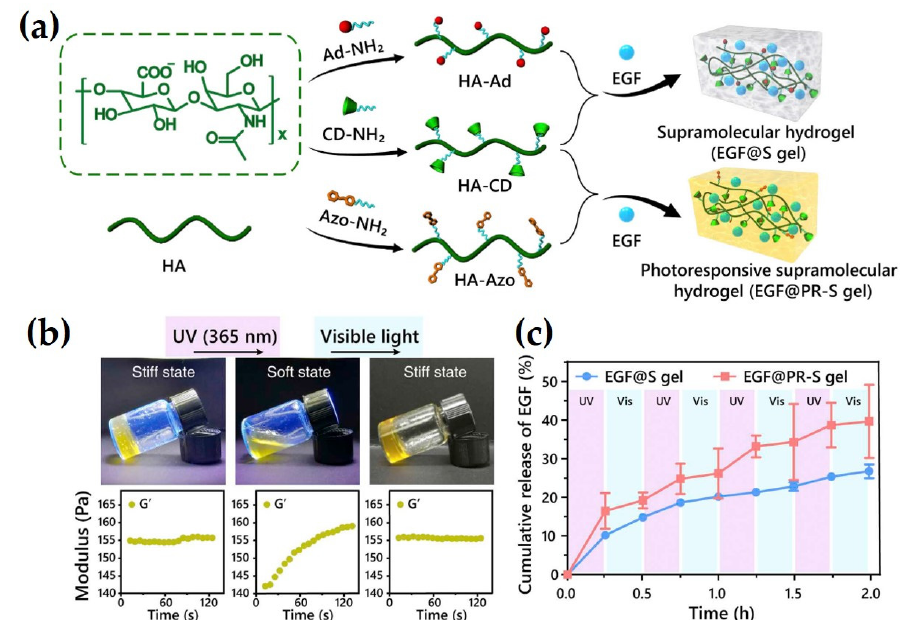
Figure 6. Schematic illustration of the synthetic procedure followed for the preparation of the photo- responsive hydrogel: ( a ) photographs showing the sol-gel transition and the corresponding moduli following irradiation with UV and visible light; and ( b ) the release profile of EGF from the hydrogels upon alternating UV and visible light irradiation ( c ). Adapted with permission from [54].